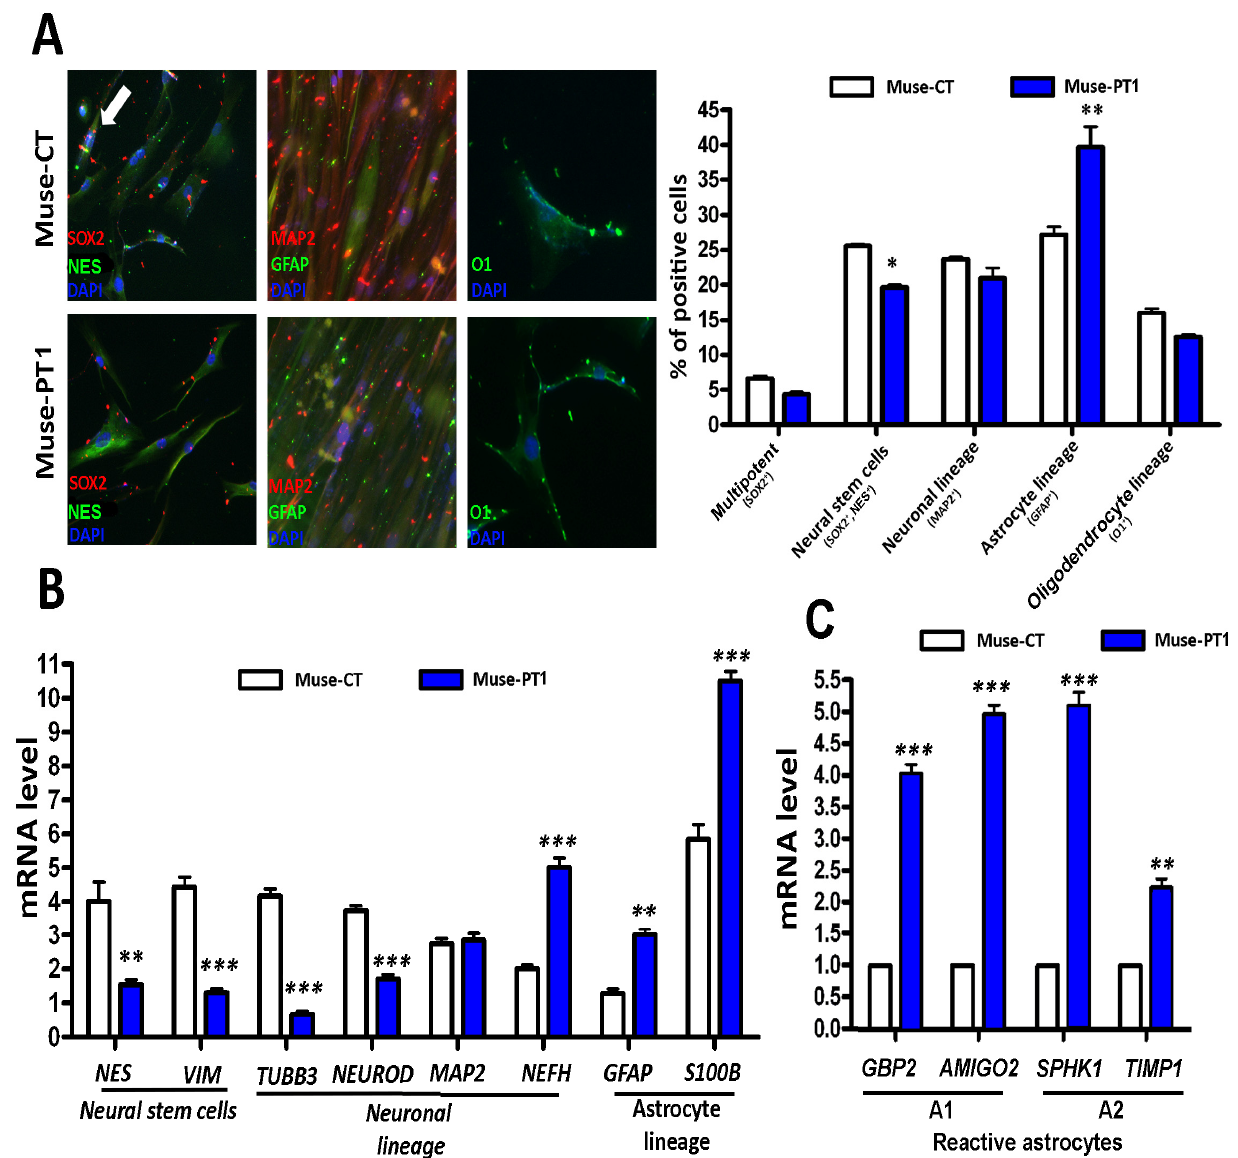
Figure 3. Neuroglial differentiation of Muse stem cells . Panel ( A ): Graph showing the percentages of multipotent Muse stem cells (SOX2+), neural stem cells (i.e., SOX2+ and NESTIN+), neuronal (MAP2+), astrocytes (GFAP+), and oligodendrocyte-committed progenitors (O1+) following neuroglial differentiation of Muse stem cells obtained from a healthy control and Patient 1. The micrographs show representative images of immunostaining on differentiated samples (200× magnification). Green and red dots in the background are due to poly-L-lysine coating present in the samples. In Muse-CT sample, the white arrow indicates SOX2/NESTIN-positive cells. Panel ( B ): Histogram showing the mRNA expression level of the indicated genes. The mRNA levels were normalized to GAPDH mRNA expression, which was selected as an internal control. NES = NESTIN; VIM = VIMENTIN. Panel ( C ): mRNA levels of reactive astrocyte markers identified by qRT-PCR. The expression level of markers was set as 1 in the sample obtained from a healthy control (i.e., Muse-CT). For all of the experiments, the symbols *** (i.e., p < 0.001), ** (i.e., p < 0.01), and * (i.e., p < 0.05) indicate statistical significance between the control and Patient 1 ( n = 3 biological replicates), and data with SD are